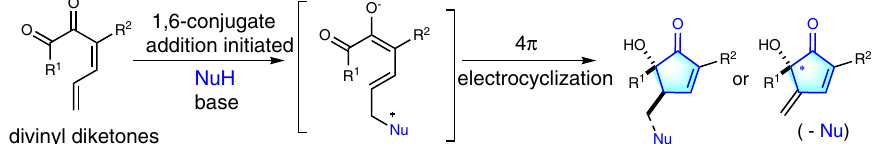
Fig. 1 Selected naturally occurring chiral cyclopentenones, the known substrates in asymmetric Nazarov cyclization for construction of chiral cyclopentenone. a Representative examples of naturally occurring cyclopentenones with a 5-hydroxy-bearing quaternary stereocenter. b Divinyl ketones: dominant substrates in asymmetric Nazarov cyclization. c Vinyl diketoesters: developed by the group of Tius. d Dienyl diketones: developed by the group of